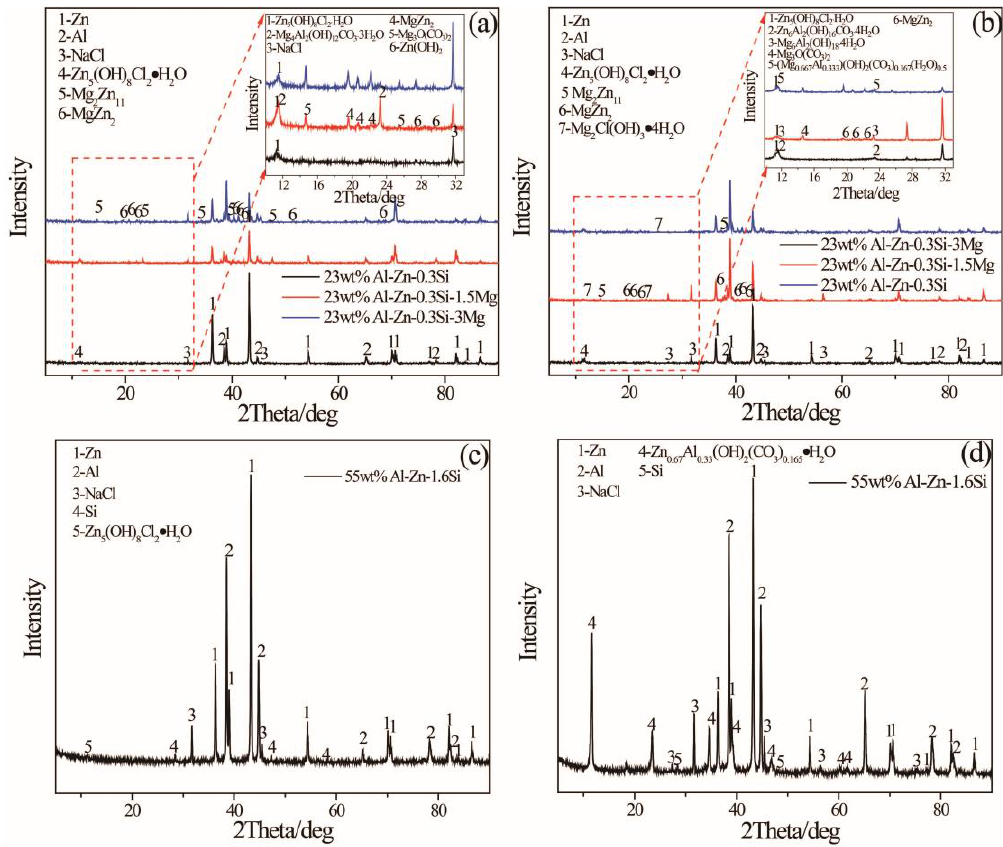
Figure 7. X-ray diffraction pattern of immersion specimen: ( a ), ( c ) 23AZS– x Mg ( x = 0, 1.5, 3) and 55AZS alloy immersing for four days, ( b ), and ( d ) 23AZS– x Mg ( x = 0, 1.5, 3) and 55AZS immersing for 59 days.